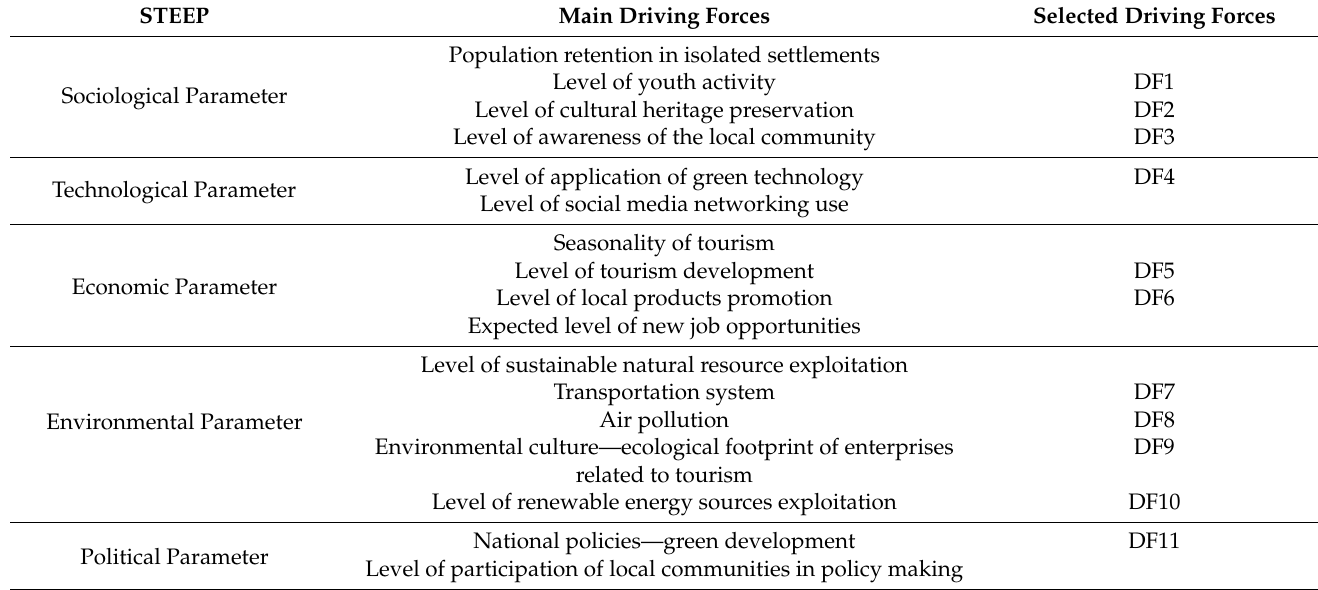
Table 1. Driving forces obtained by STEEP analysis and selected driving forces for tourism develop- ment scenario in Lefkada island,